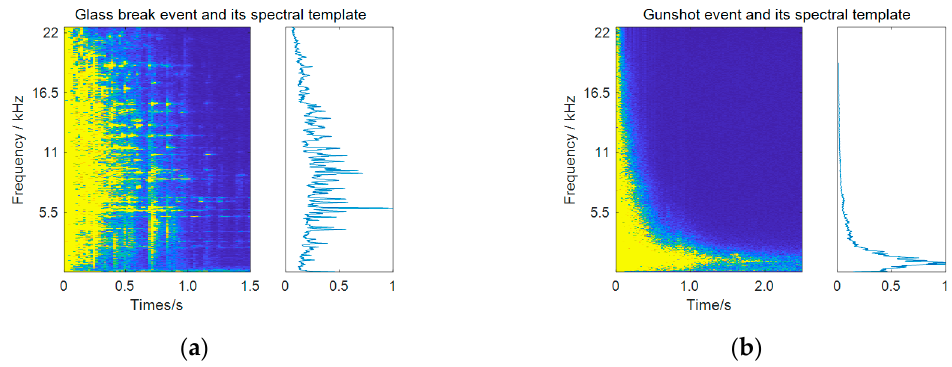
Figure 4. Spectrograms and spectral templates of ( a ) a glass break event and ( b ) a gunshot event.